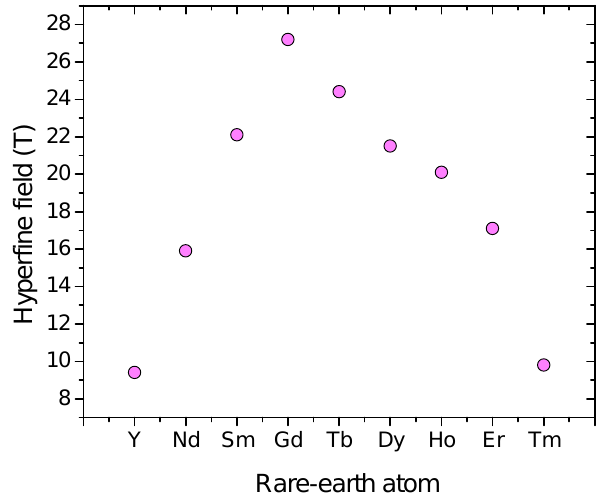
Figure 8. Hyperfine field for different R 2 Fe 17 [38,42,99–104].